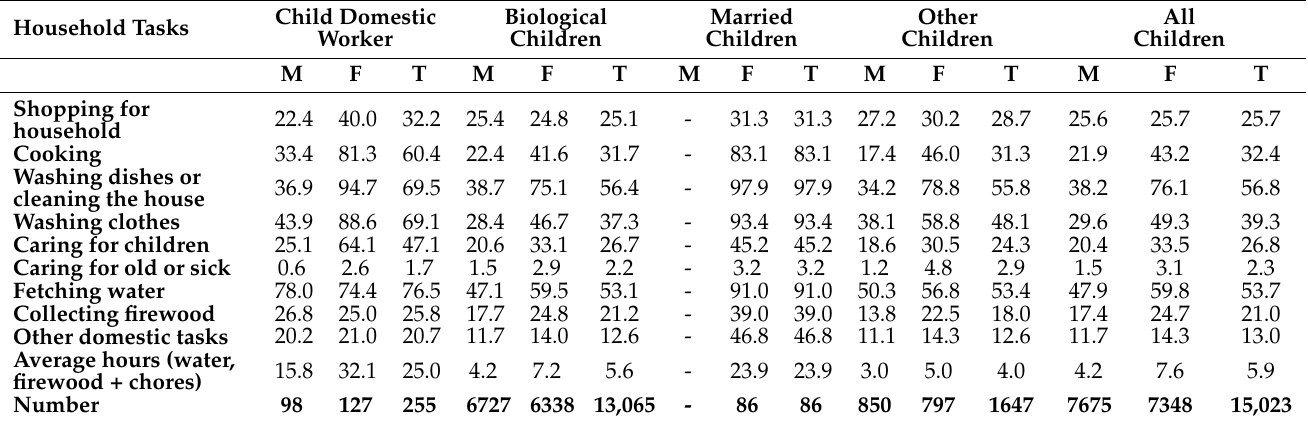
Table 5. Proportion of Children engaged in household tasks by sex ( N = 15,023,